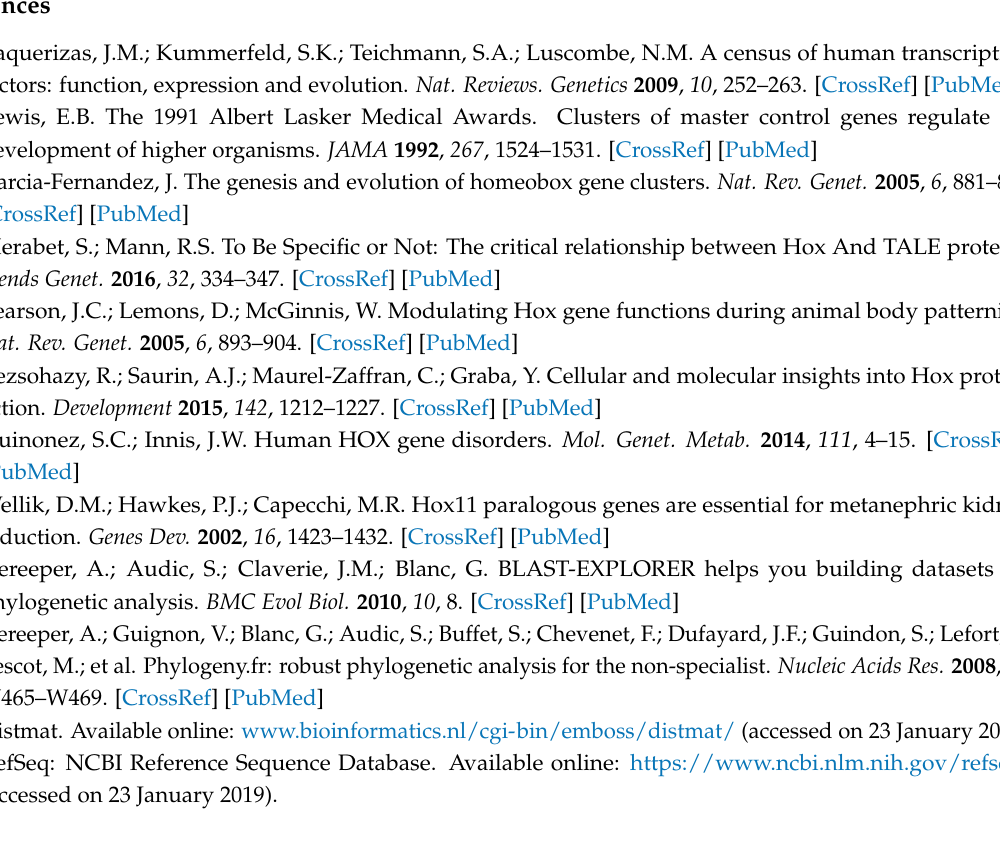
Figure S1: Phylogenetic analysis of the 39 human HOX genes, Table S1. Distance values comparing all HOX proteins and all HOX protein